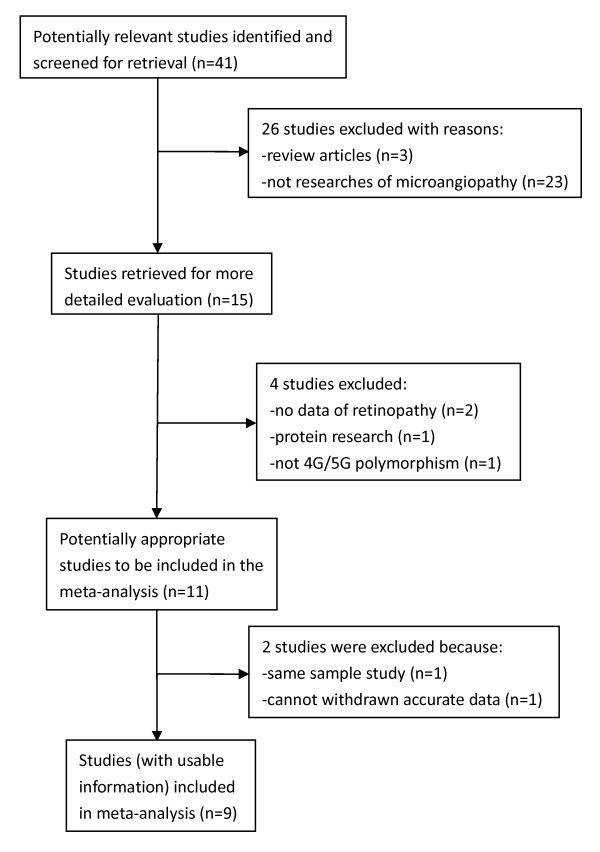
Flow chart of included studies.